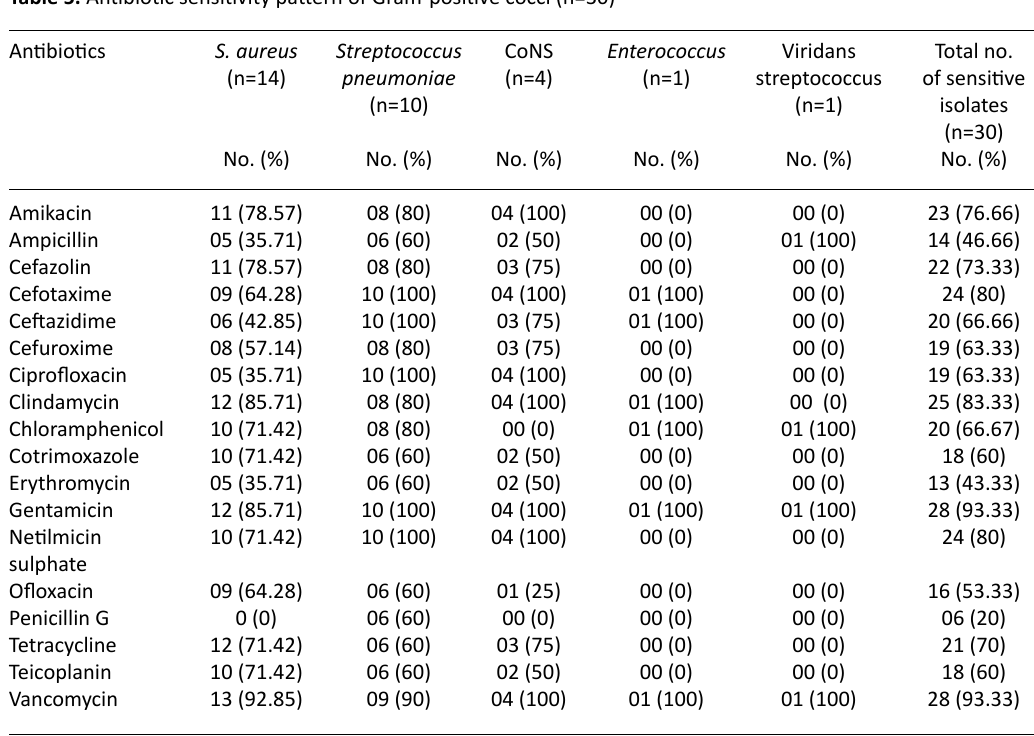
Table 5. Antibiotic sensitivity pattern of Gram-positive cocci (n=30) Antibiotics S. aureus Streptococcus CoNS Enterococcus Total no.